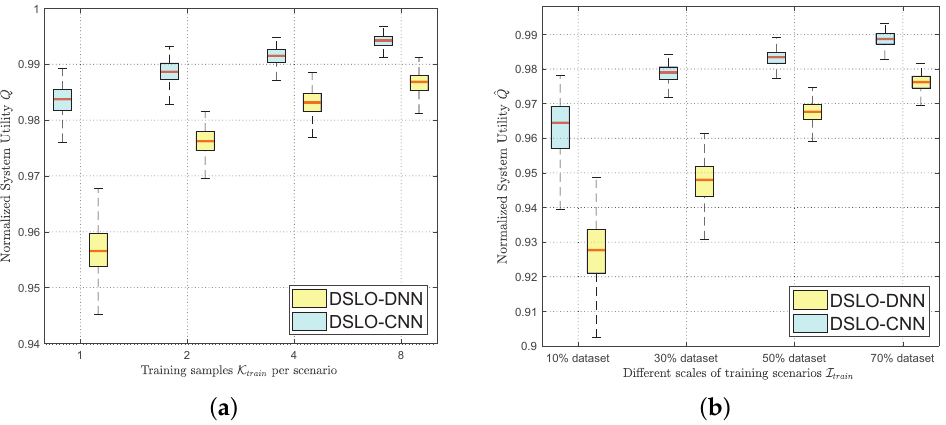
Figure 11. Test performance with different scales of the training dataset. ( a ) |I train | = 70% |I| ; ( b ) |K train | =